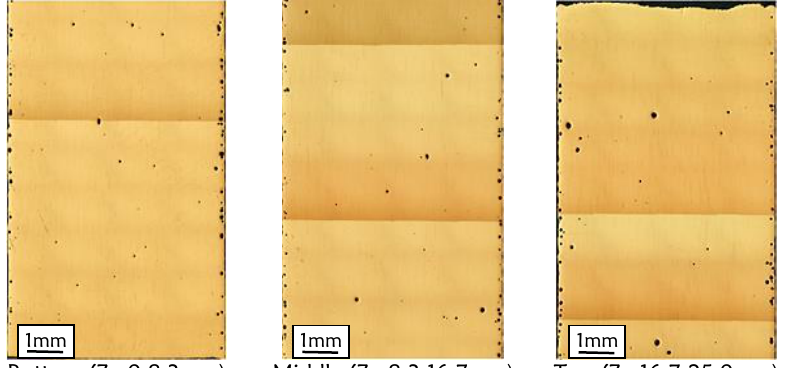
Figure 37: Composite image of SLM IN718 specimens sectioned at different heights. High pore density is seen at the part boundaries [84].